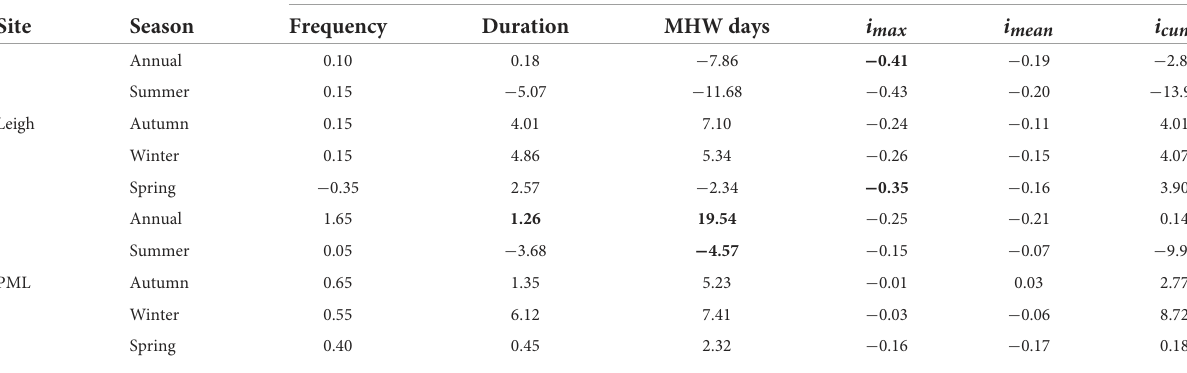
TABLE 3 Trends in annual MHW statistics at Leigh and PML (significant trends in